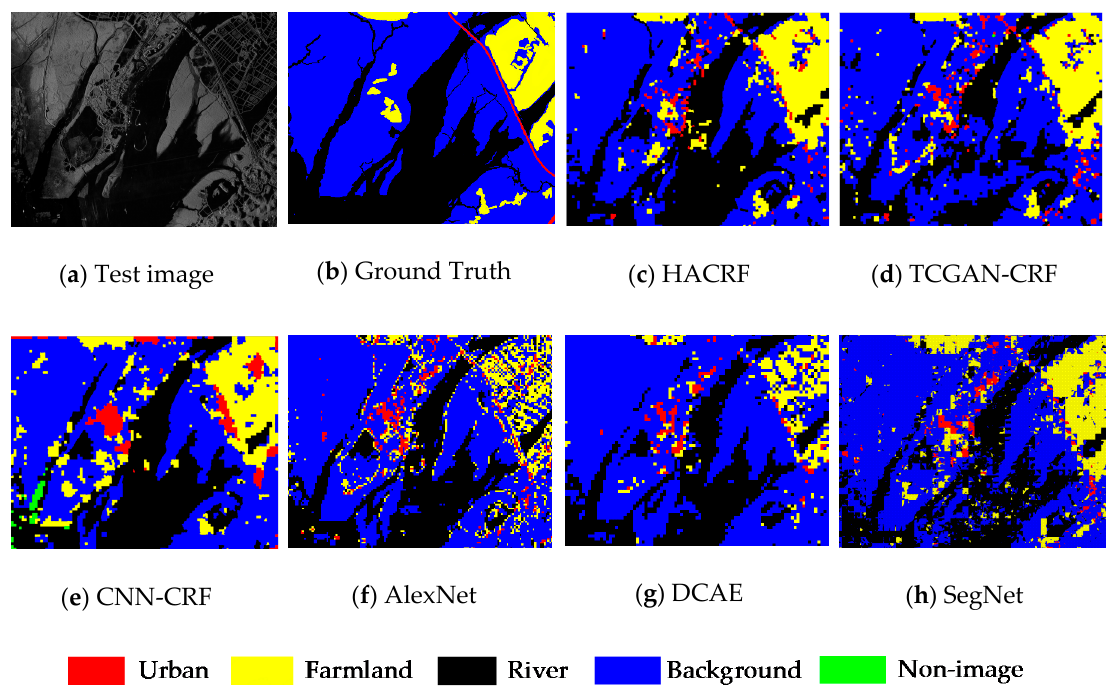
Figure 8. Segmentation results of six models on FangChengGang dataset. ( a ) Input image; ( b ) ground truth; ( c ) HACRF; ( d ) TCGAN-CRF; ( e ) CNN-CRF; ( f ) AlexNet; ( g ) DCAE; ( h ) SegNet.